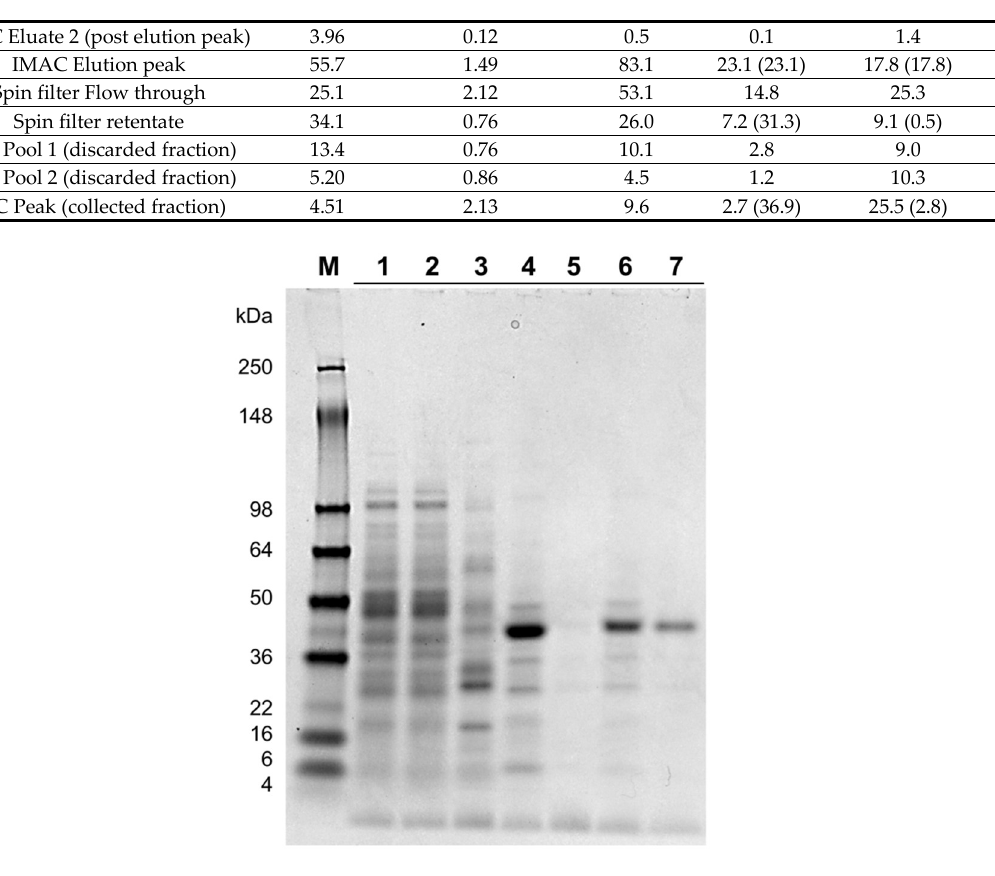
Figure 1. SDS-PAGE image to evaluate the purification process of Ct XR. The target protein is located at a height between 36 and 50 kDa with an estimated mass of 41 kDa. M: Protein ladder (SeeBlue